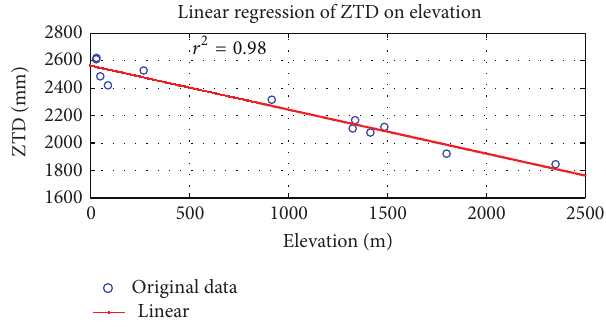
Figure 4: Plot of GNSS ZTD against station